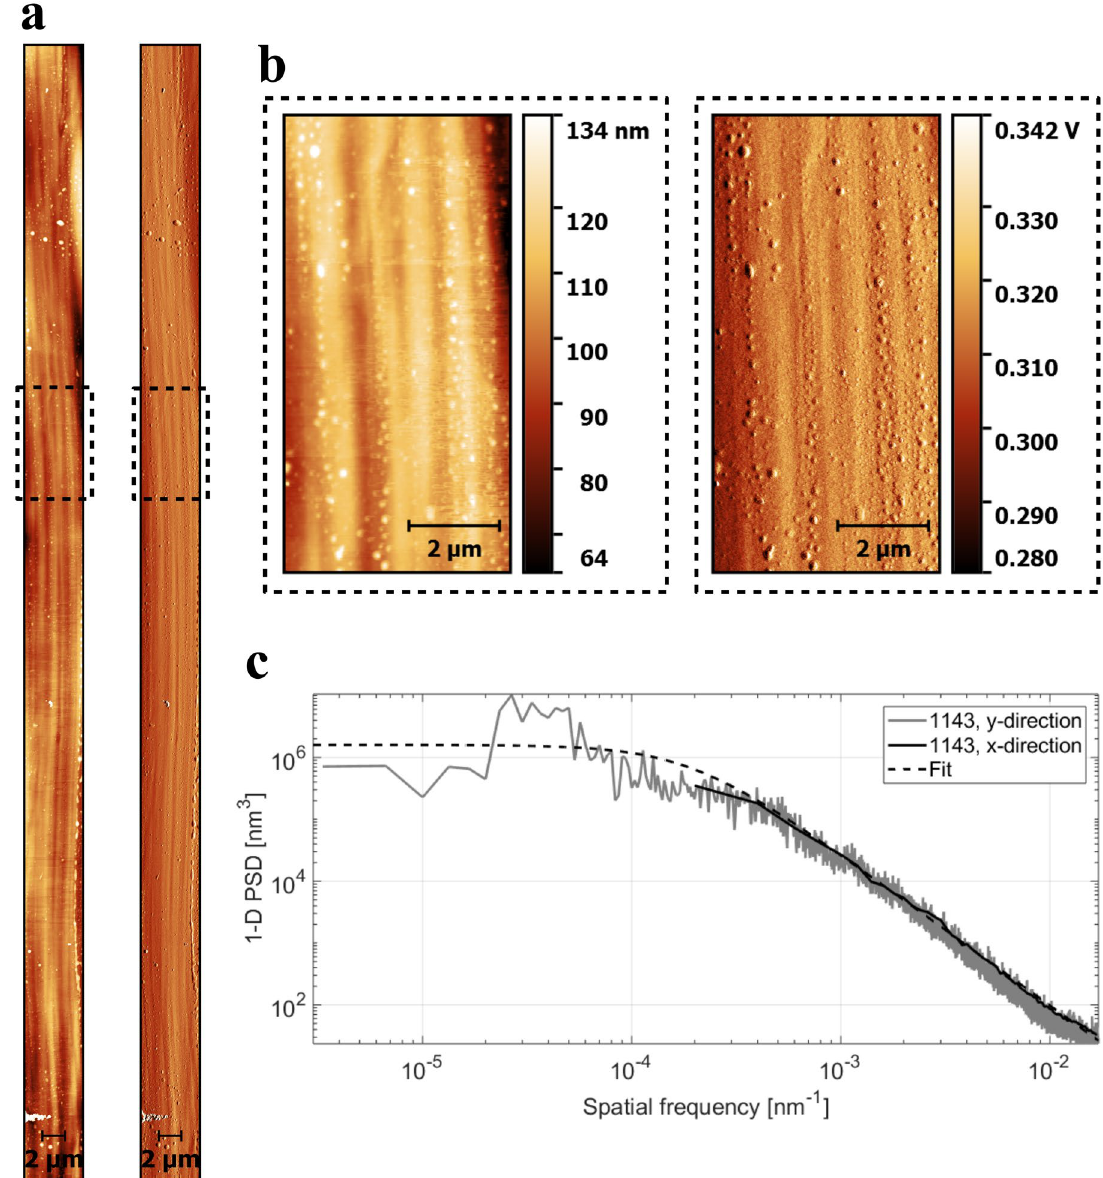
Figure 2. Exemplary atomic force microscopy (AFM) analysis of fibre 1143 at one location. ( a ) Full range AFM image (left: height, right: amplitude). ( b ) Zoom-in of the height and amplitude AFM images in the indicated (5 × 10) µm 2 section. The depicted height mode AFM images were further treated by a median of differences row alignment. (c) PSD along x- and y-directions for fibre 1143, together with the corresponding ABC-fit curves. The data for fibre 1144 may be found in Figure